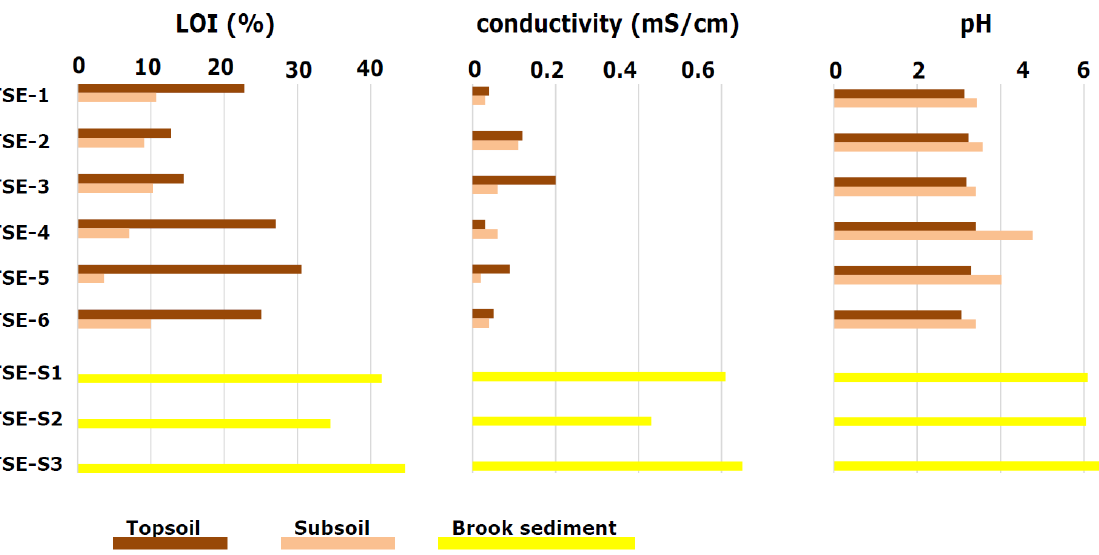
Figure 4. The variation in the organic matter (estimated by loss on ignition, LOI), electrical conduc- tivity and pH value in topsoils, subsoils and in brook sediments of the Einsiedel Reservoir.